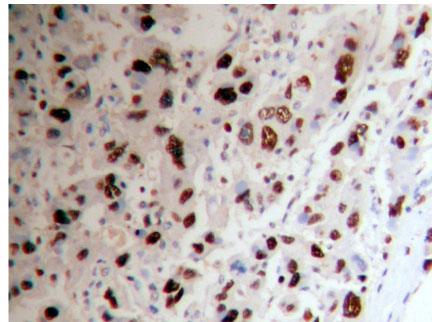
Adrenocortical carcinoma Ki-67 ( + +) SuperisionTM two footworks